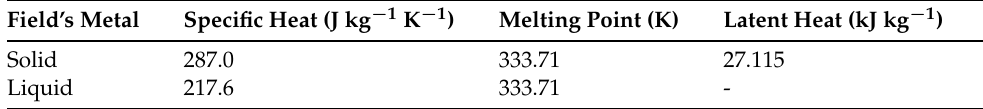
Table 3. Thermal analysis of the Field’s metal.